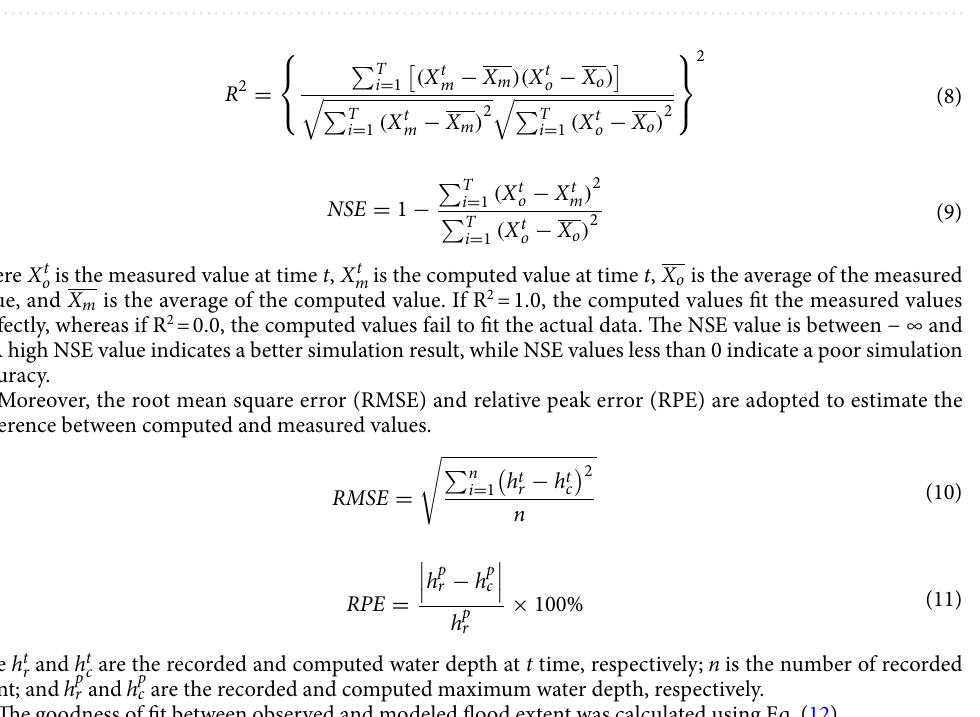
Figure 2. The lifting process of a manhole. ( a ) When h 1 D = h 2 D + z 2 D , the overflow process occurs immediately when the head exceeds this critical point in the FSMI method. ( b ) When h 1 D > h 2 D + z 2 D , the overflow process does not occur in the FSMIC method. ( c ) The critical pressure head is exactly high enough to lift the manhole cover in the FSMIC method. ( d ) The overflow process occurs in the FSMIC method when the manhole cover is lifted in vertical displacement by the difference between the pressure head and the critical pressure